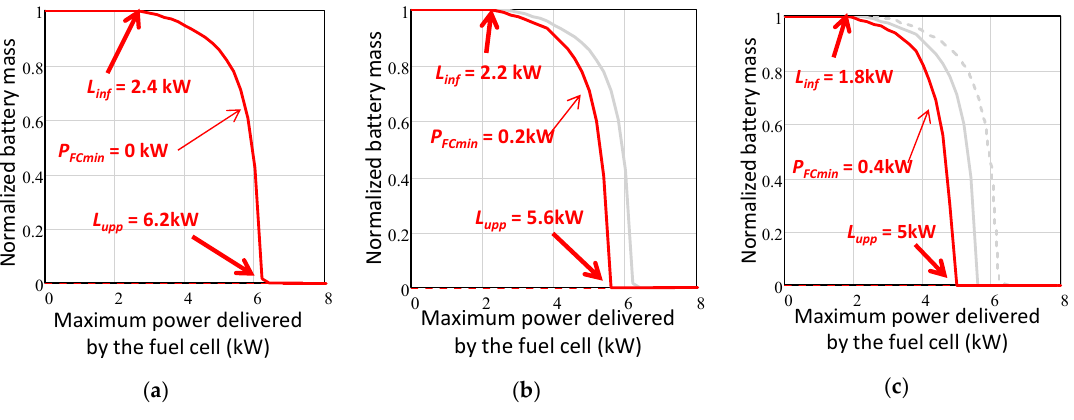
Figure 5. Influence of the fuel cell (FC) minimum power on the normalized battery mass: ( a ) FC minimum power of 0 W. ( b ) FC minimum power of 200 W. ( c ) FC minimum power of 400 W.